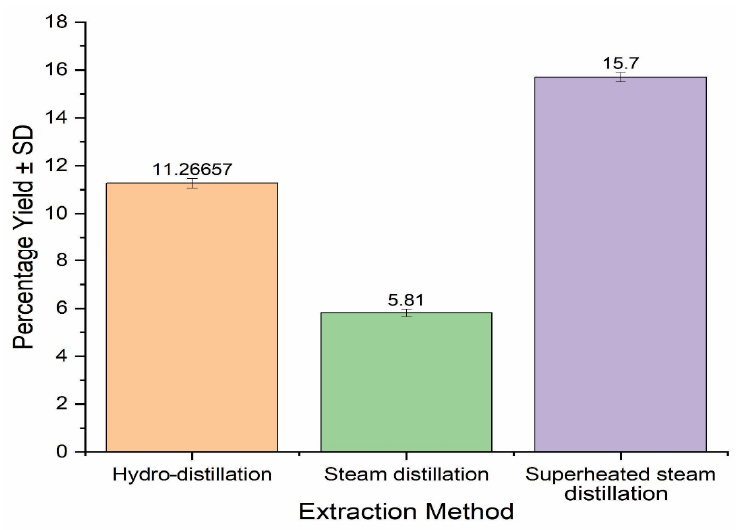
Figure 1. Percentage yields of S. aromaticum essential oils derived from different extraction meth- ods.